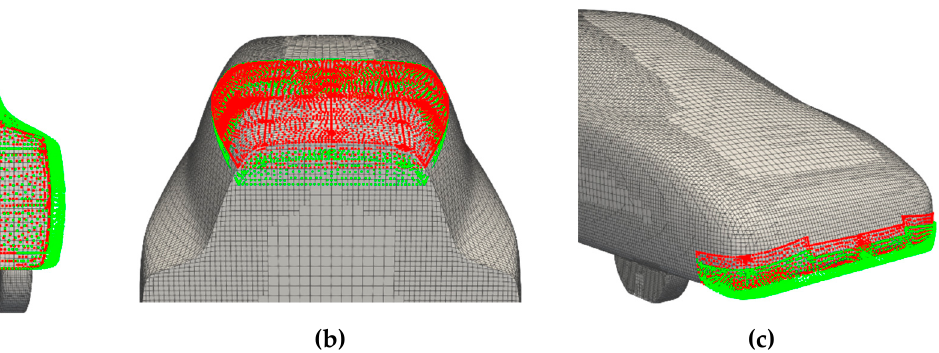
Figure 4. Boat tail ( a ), roof drop ( b ) and front spoiler ( c ) shape modifiers of the ASMO geometry.